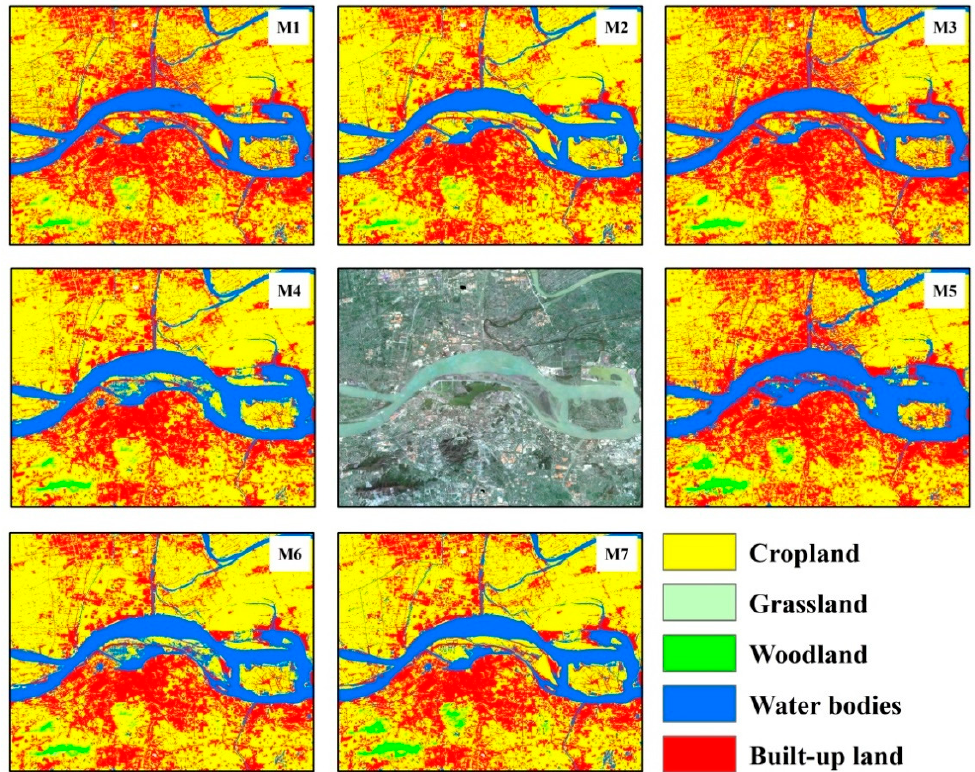
Figure 6. Comparison of the pixel-based classification results in a typical region. M1–M7 indicate the classification results of the seven pixel-based models listed in Table 3, respectively. The central subfigure is Landsat 8 OLI true color image.